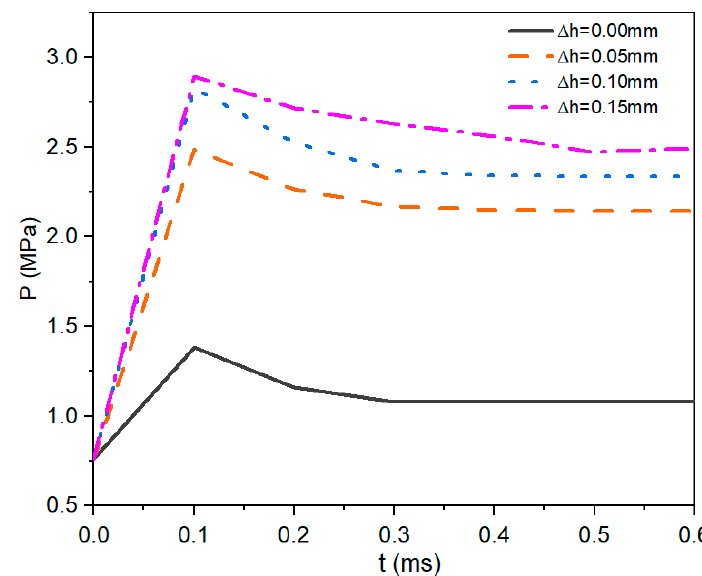
Figure 16. Transient pressure in receiving holes after erosion.